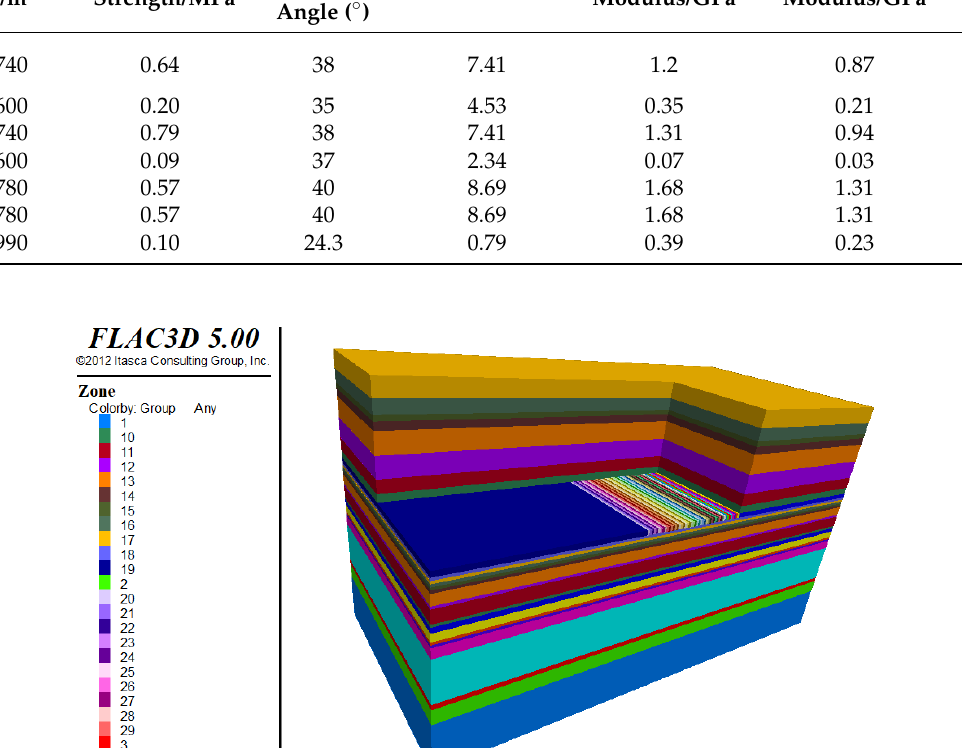
Figure 6. Numerical simulation model.